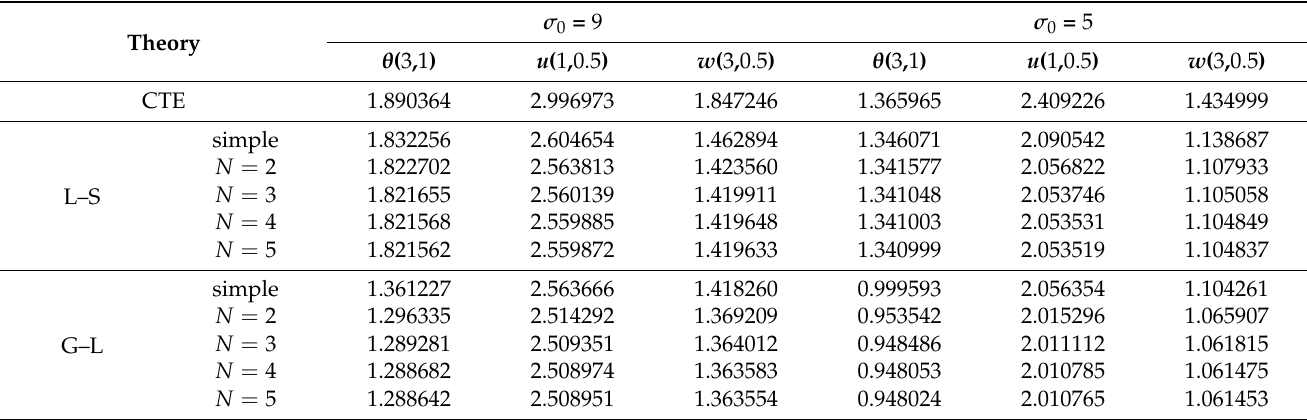
Table 1. Effect of initial stress σ 0 on the temperature θ and displacements u and w of the rotating half-space with initial pressure ( (cid:112) = 10).